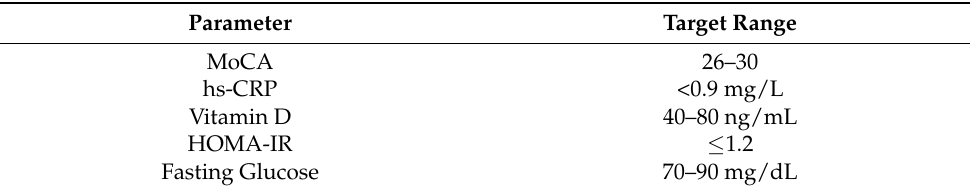
Table 3. Target ranges of the parameters reported in this